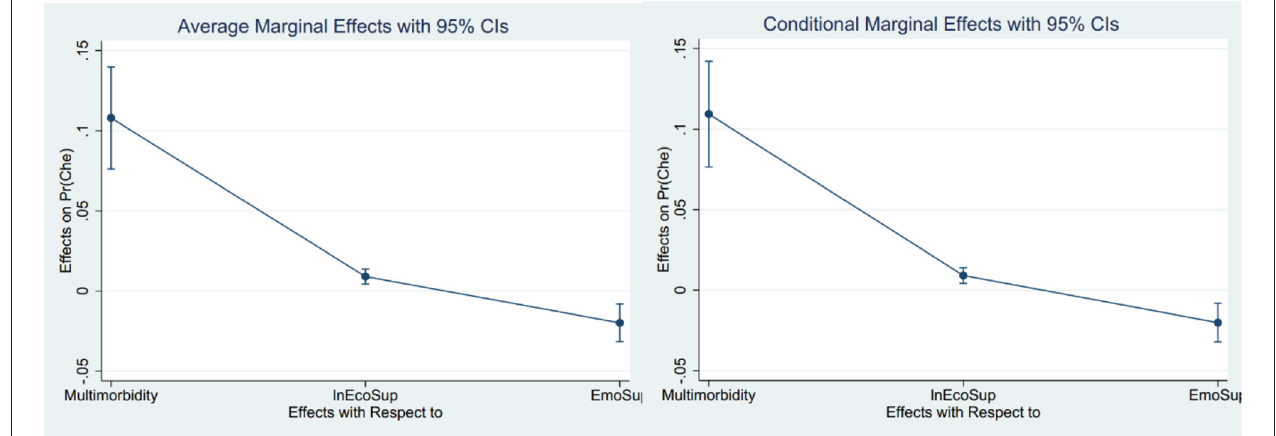
FIGURE 2 | Visualization of the results of the marginal effect analysis of the core independent variables.